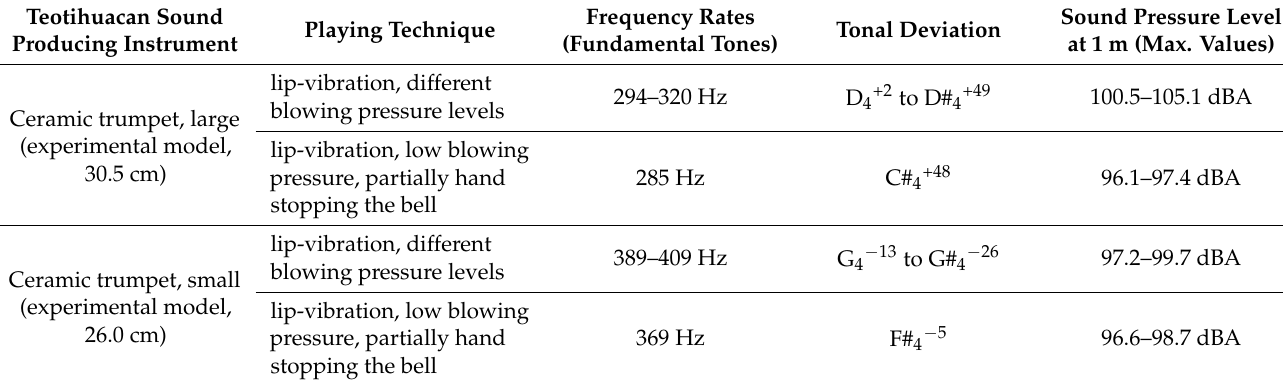
Figure 17. Spectral components of ceramic trumpet. Experimental model, low blowing pressure: ( a ) spectrogram; ( b ) spec- trum (Sample S7). Table 3. Acoustic data sheet of the analyzed ceramic trumpets (experimental